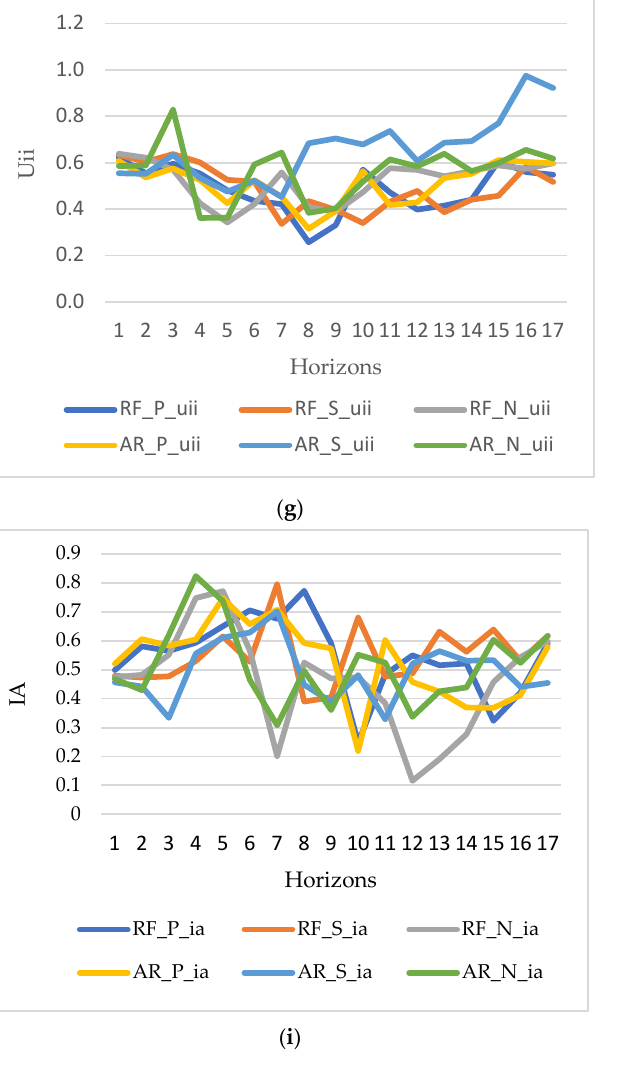
Figure 8. Comparison of the prediction accuracy statistics of all single models RF_ and AR_ (on the left) and the corresponding averaging models aRF_ and aAR_ (on the right): ( a , b ) RMSE; ( c , d ) NMSE; ( e , f ) FB; ( g , h ) Uii; ( i , j ) IA.